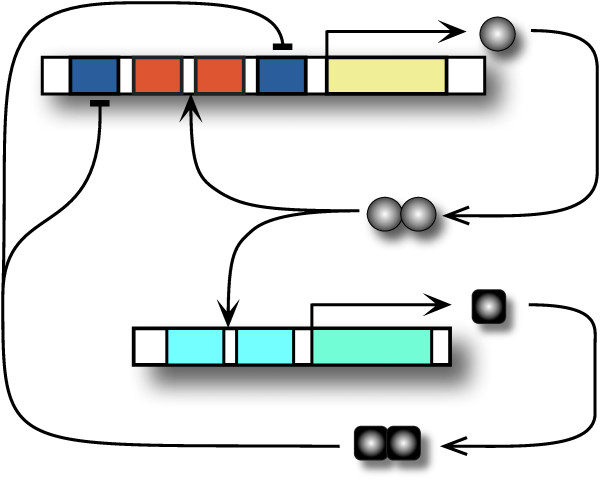
The scheme of the experimental design from [6].